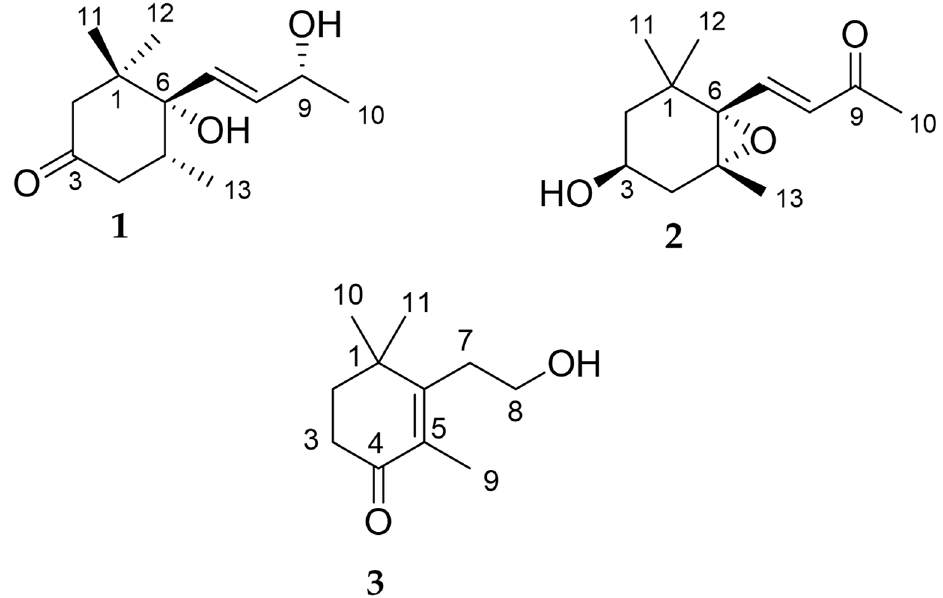
Figure 3. The molecular structures of the identified phytotoxic compounds 1 , 2 , and 3 (4,5-dihydrovomifoliol, 3-hydroxy-5 α ,6 α -epoxy- β -ionone, and 3-(2-hydroxyethyl)-2,4,4-trimethyl-2cyclohexen-1-one) from the Albizia richardiana extract.